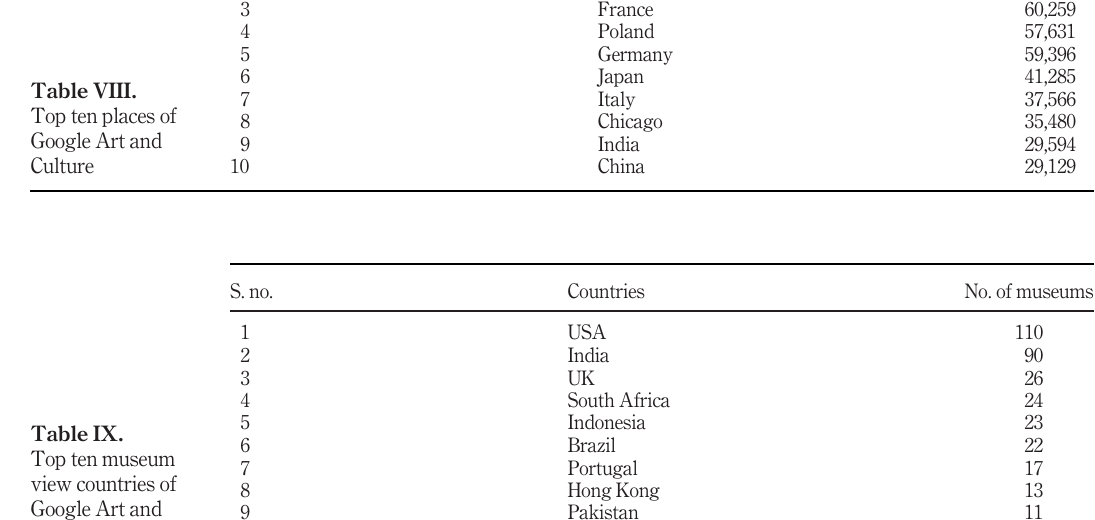
view countries of Google Art and